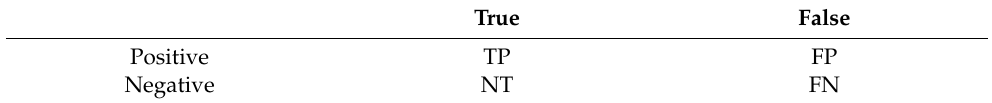
Table 4. Confusion matrix.